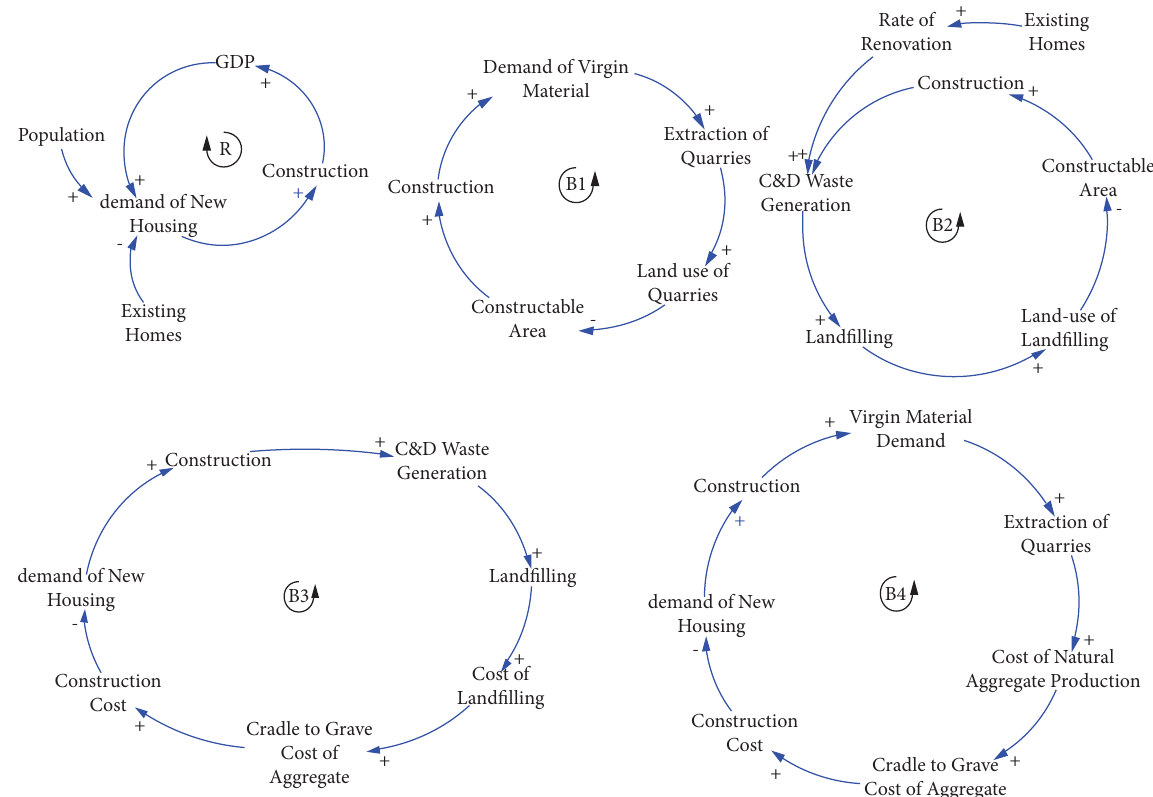
Figure 2: (R) Te causal loop of impacts of the population and GDP on construction. (B1) Te causal loop of the impact of mining on reducing construction. (B2) Te causal loop of the impact of the C&D waste generation on reducing construction. (B3) Te causal loop of the impact of the C&D waste cost on reducing the demand for housing. (B4) Te causal loop of the impact of the cost of natural stone materials production on the reduction of housing